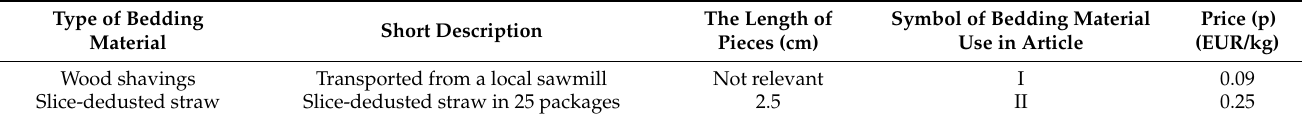
Table 1. Characteristics of tested bedding materials.